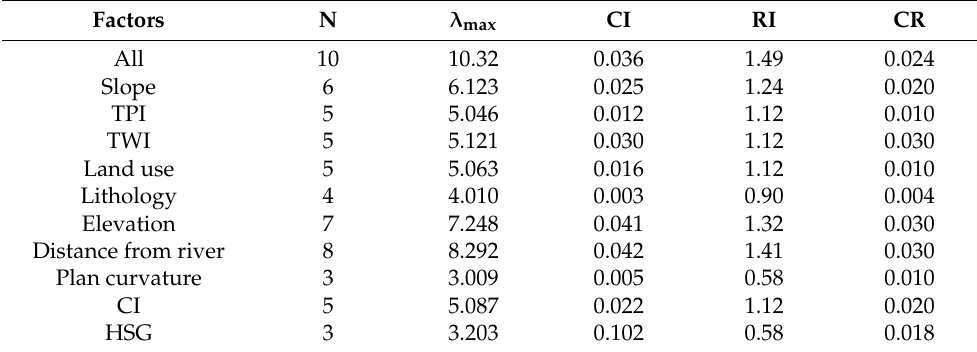
Table 5. Properties of comparison matrices in the previous table.